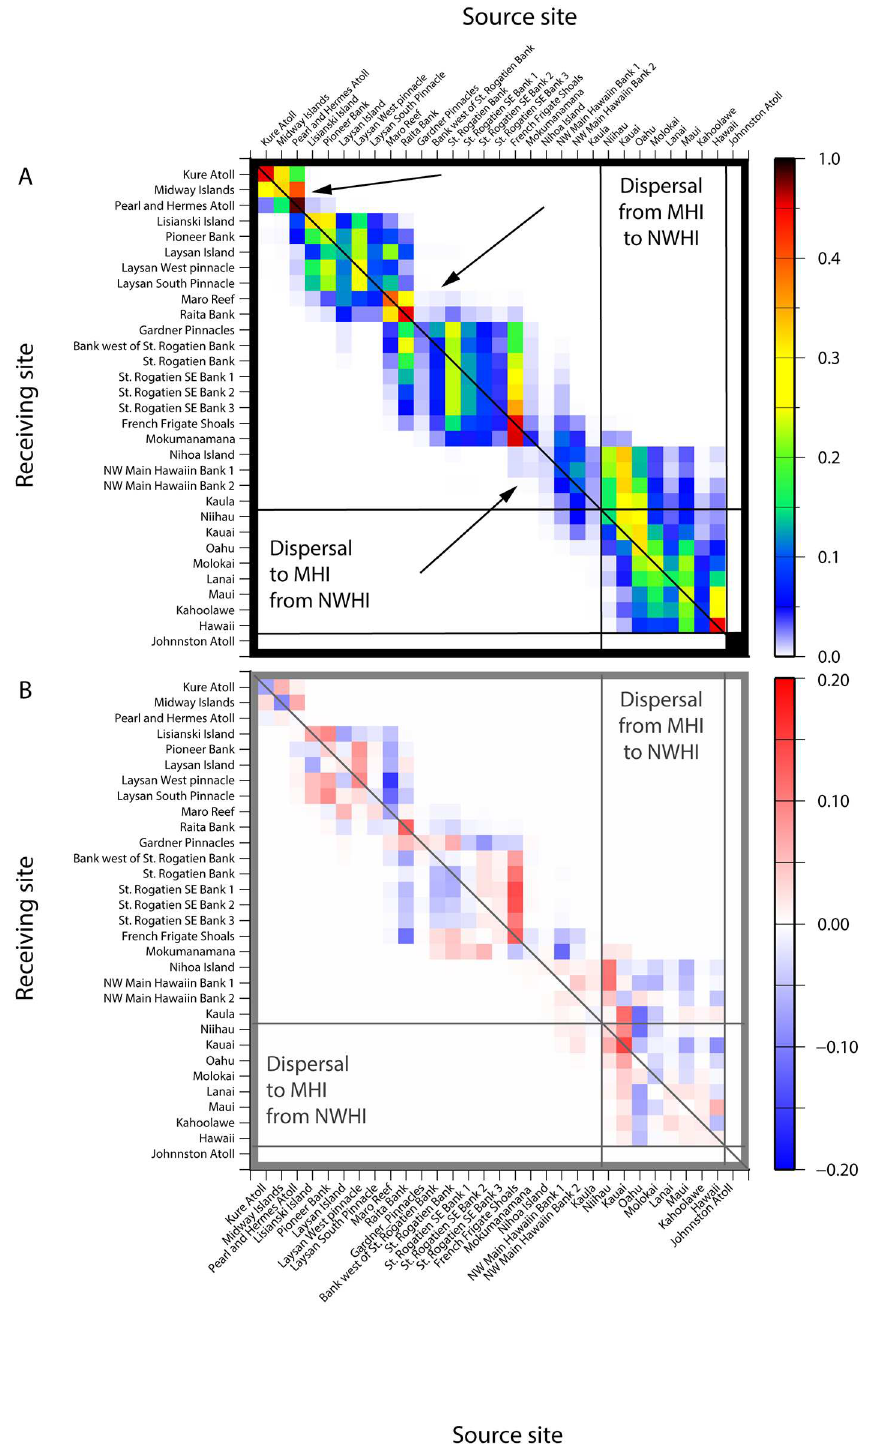
Fig 2. Potential Connectivity matrix for the Hawaiian Archipelago. (A) The values in each cell are “settlement” probabilities scaled to the receivingsite for year-roundparticle release. Arrows indicatedthe breaks mentioned in the text. Each row in the matrix adds up to 1. High values (red) indicate high connectivity and low numbers(blue) indicatelow connectivity, and white cells denote no connectivity. (B) Differencematrix showingthe difference in connectivitybetweenyear-roundand May-June particle release. The